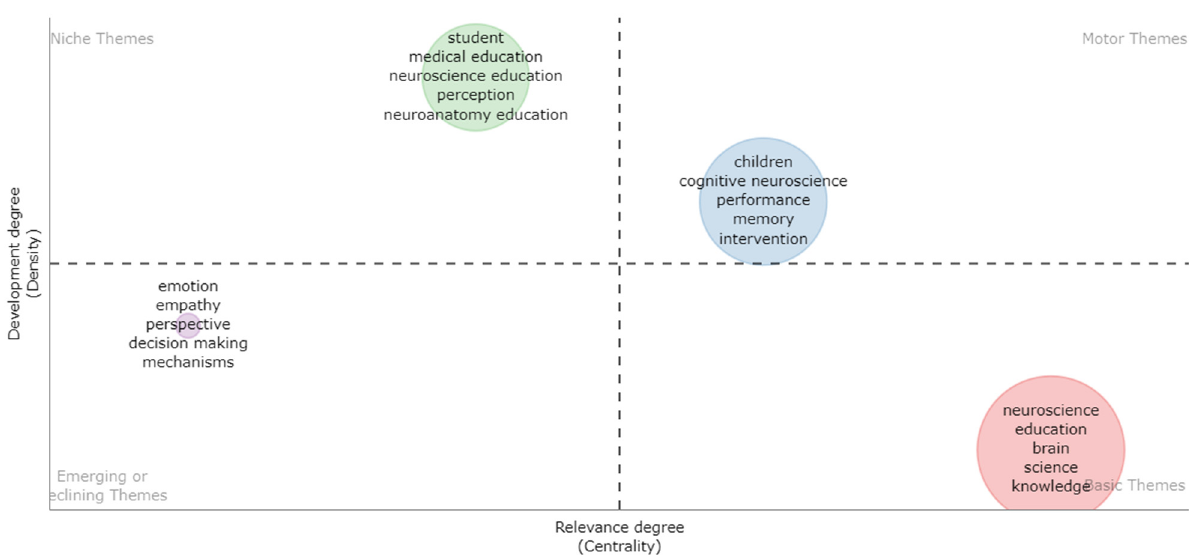
Figure 8. Strategic diagram for neuroscience in the field of education for 2014–2022.